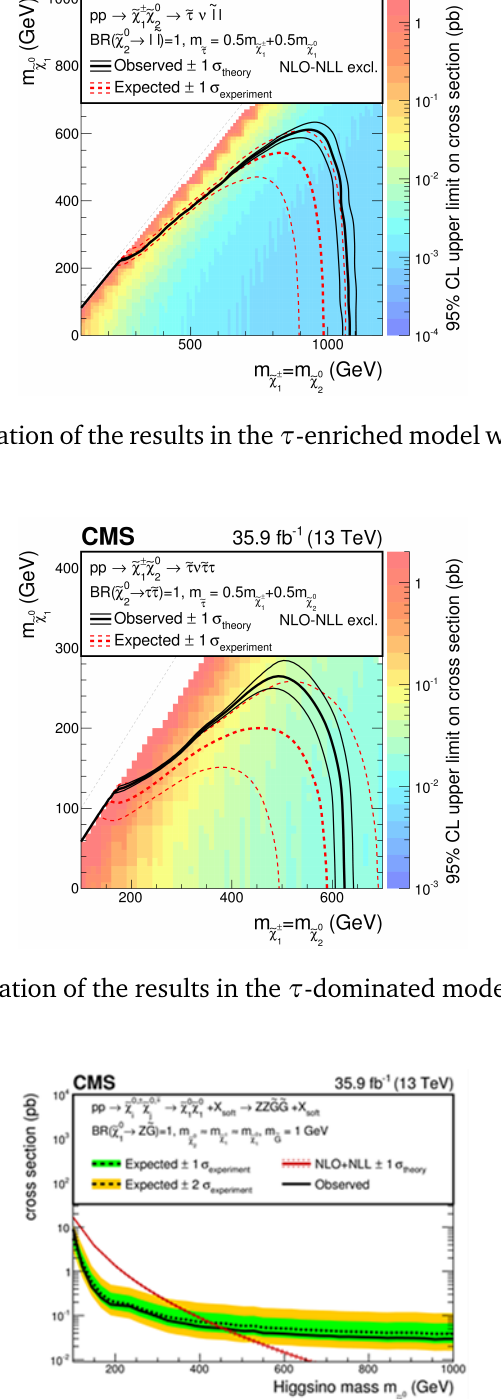
Figure 16: Interpretation of the results in the ˜ χ 0 GGM SUSY, where higgsino masses are excluded up to 295 GeV. In R-parity-violating simplified models with decays of the lightest supersymmetric particle to charged leptons, lower limits of 1.46 TeV, 1.06 TeV, and 2.25 TeV are placed on wino, slepton and gluino masses, respectively (see Figures 23, 24, 25, 26 and